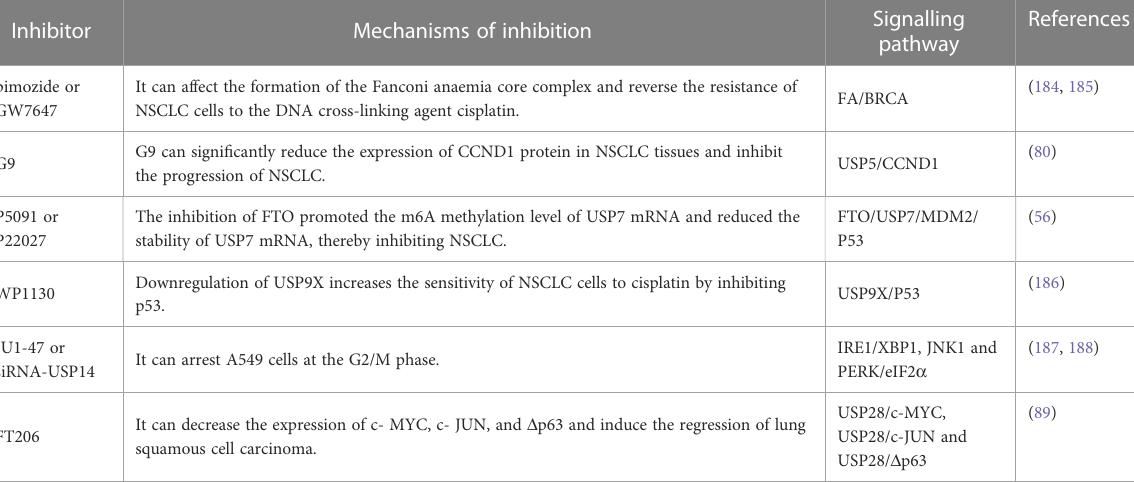
TABLE 2 Speci fi c protease inhibitors used in the treatment of NSCLC.